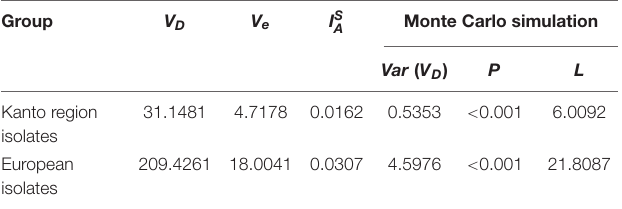
TABLE 1 | Linkage disequilibrium for single nucleotide polymorphism (SNPs) from Salmonella Chester isolated in the Kanto region of Japan or Europe. Group V D V